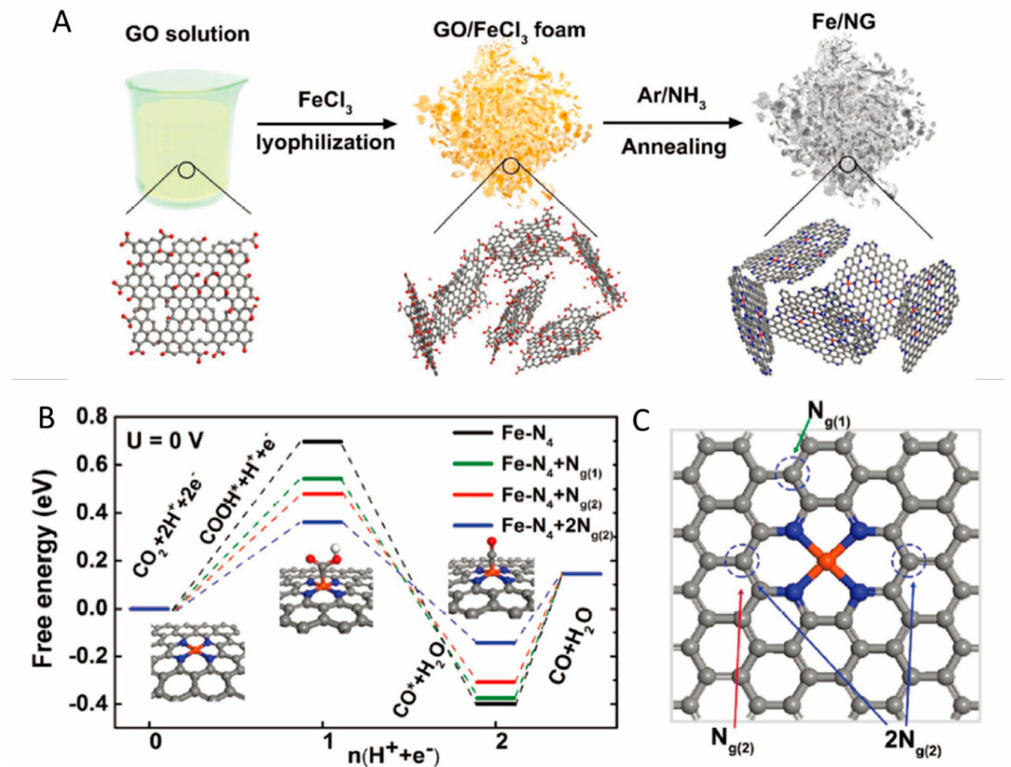
Figure 7. ( A ) The synthesis method of the Fe / NG catalyst; ( B ) free energy diagram showing mechanism of CO 2 reduction to CO; and ( C ) the structure for Fe-N 4 moieties on layered graphene showing nitrogen-substitution. Reprinted with permission from